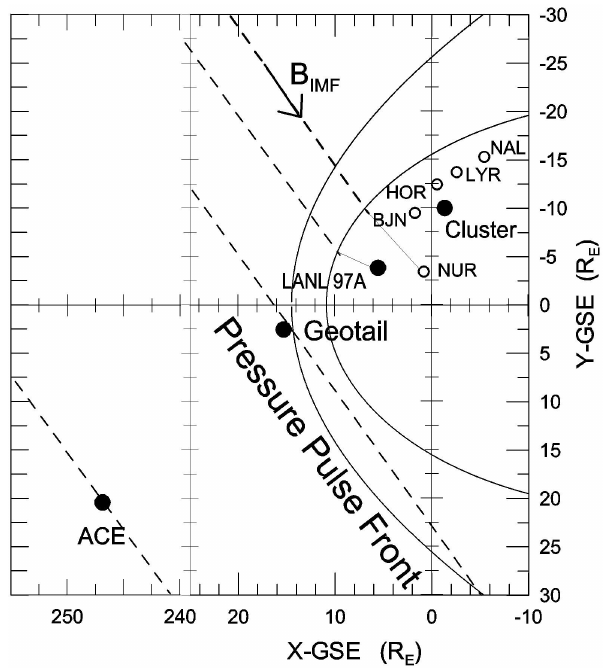
Fig. 3. Geotail, ACE, LANL 97A and Cluster 3 satellite positions (solid circles) projected over the XY GSE plane are shown for the event of day 181, 2001, at 05:00 UT. The IMF direction and the propagating pressure pulse front in the solar wind are also drawn (dashed lines). The points NUR, BJN, HOP, LYR and NAL (open circles) are the conjugate points (determined via the T96 model) for these stations over the XY plane.